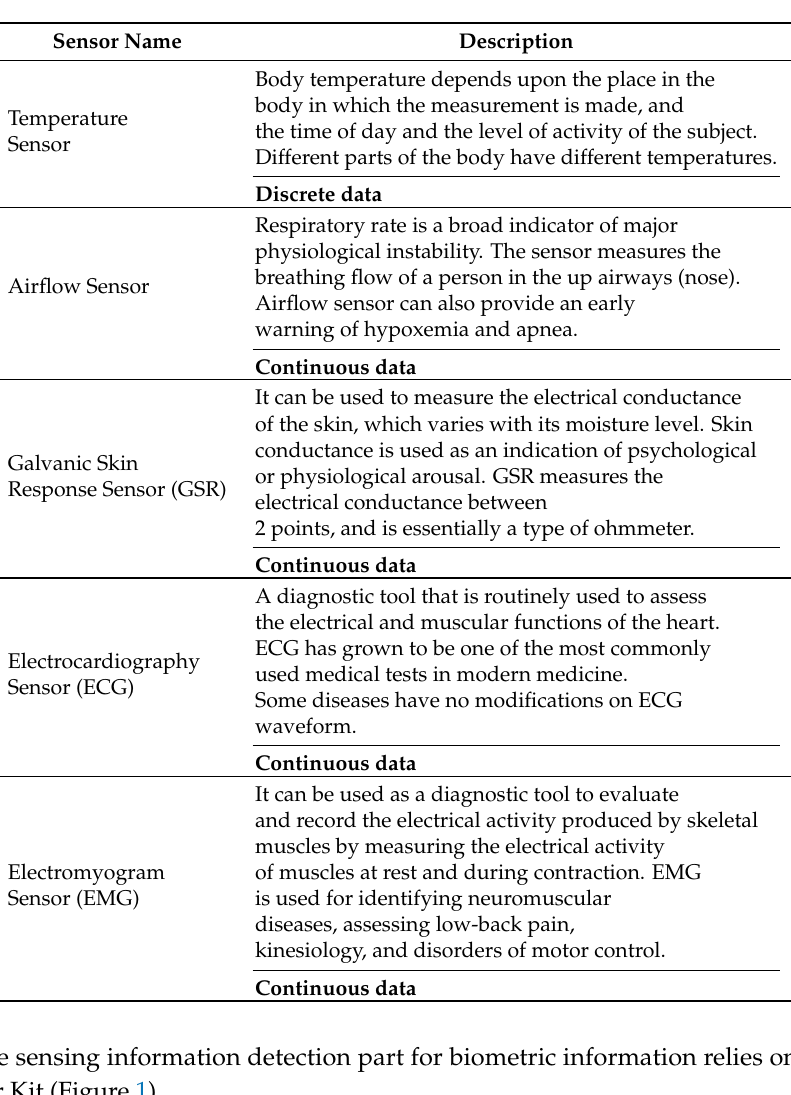
Table 1. eHealth sensors.